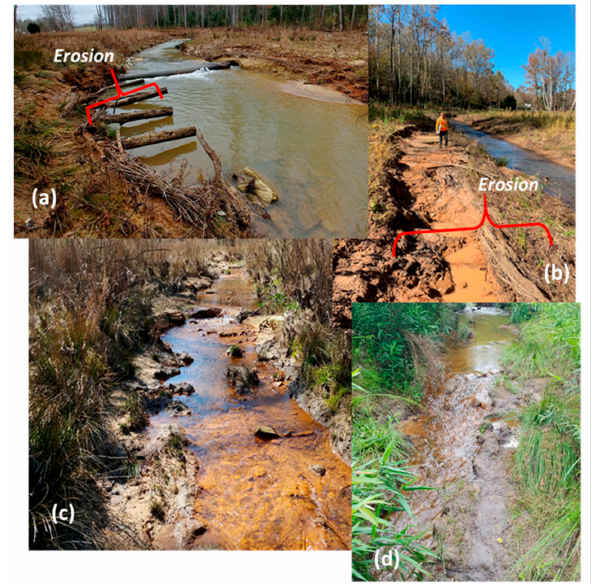
Figure 11. ( a , b ) Erosion that occurred along the lower reaches of Big Harris Creek near the down- stream terminus of the project. Bank erosion was presumably enhanced by the relatively erodible nature of the sandy legacy deposits (or reworked legacy deposits) that form the channel banks; ( c , d ) exposed precolonial deposits along bed of reconstructed channel of Stick Elliott Creek. Note that knickpoints developed in the resistant precolonial